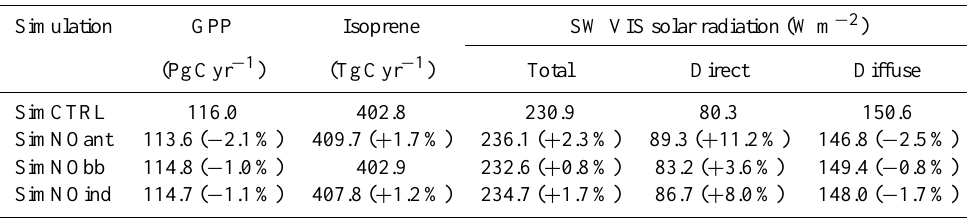
Table 3. Global annual average gross primary productivity (GPP), isoprene emission, and shortwave visible (SW VIS) total, direct, and dif- fuse solar radiation as simulated by NASA ModelE2-YIBs in the control and sensitivity present-day simulations. For sensitivity simulations, percentage changes compared to the control simulation are indicated in parentheses and reported only if changes are statistically significant at the 95% confidence level.